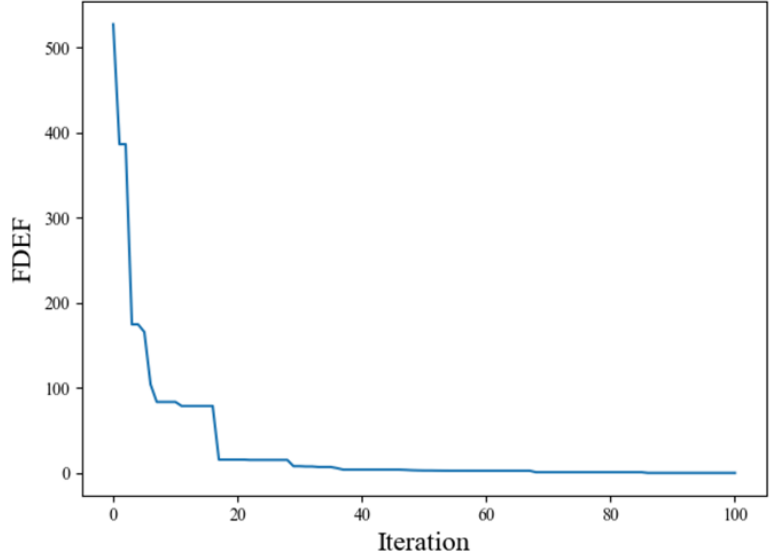
Figure 4. FDEF after 100 iterations by MFO -ESN.